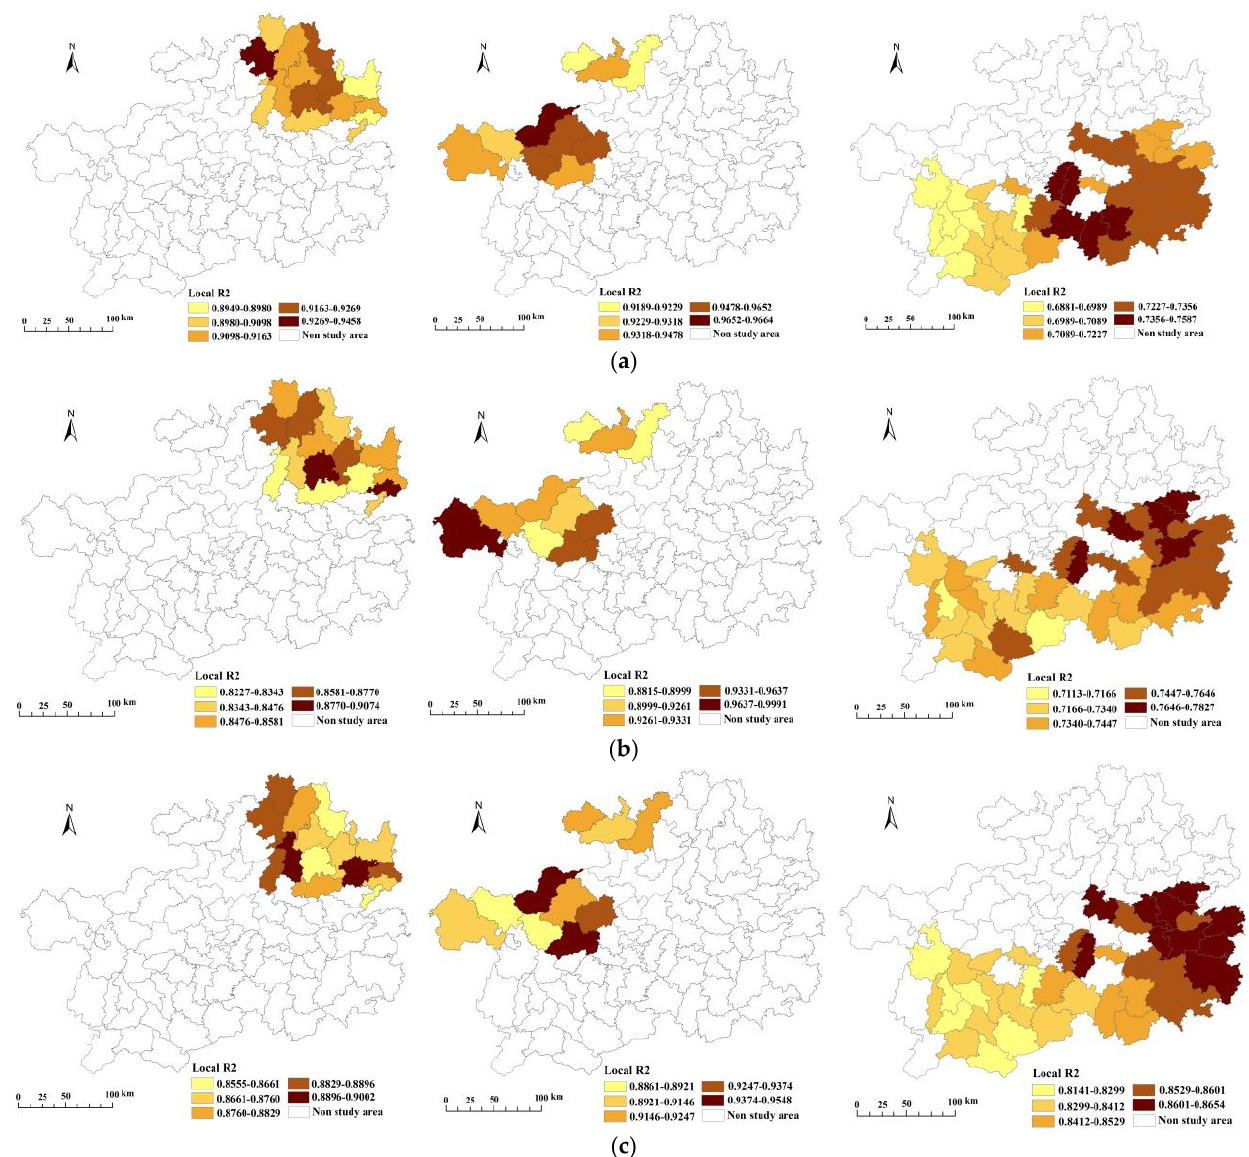
Figure 6. Local R 2 distribution of the GTWR model of the three areas in 2003, 2008, and 2011. ( a ) 2003. ( b ) 2008. ( c ) 2011. ( b ) 2008. ( c )